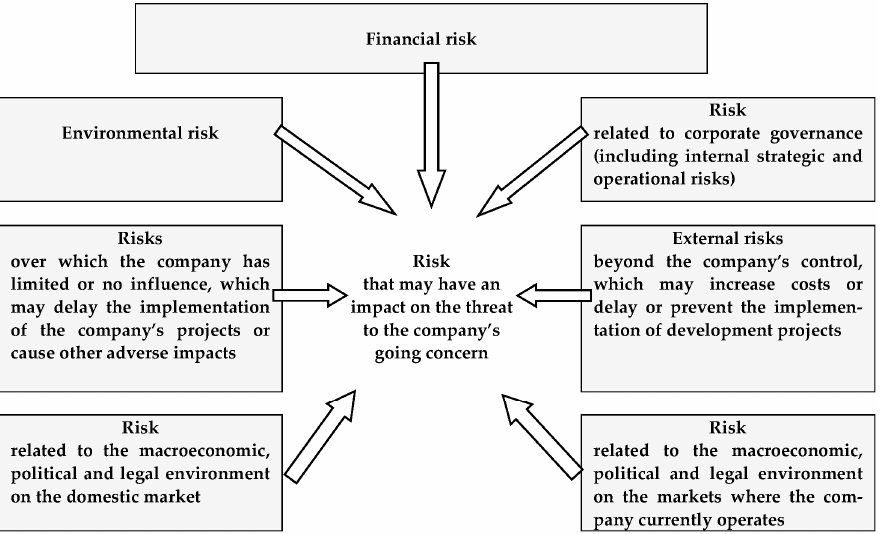
Figure 1. Idea of classifying risks by groups in the context of the impact on continued operations of companies from the construction and property development industry.